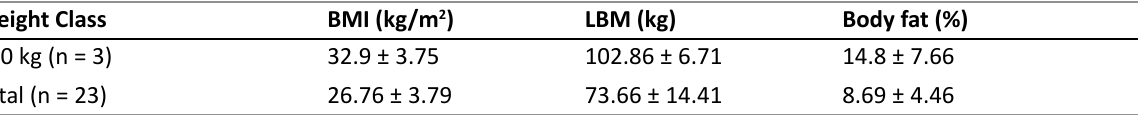
Table 3. Mean and standard deviation of girth of the elite Azerbaijani senior Greco-Roman wrestlers